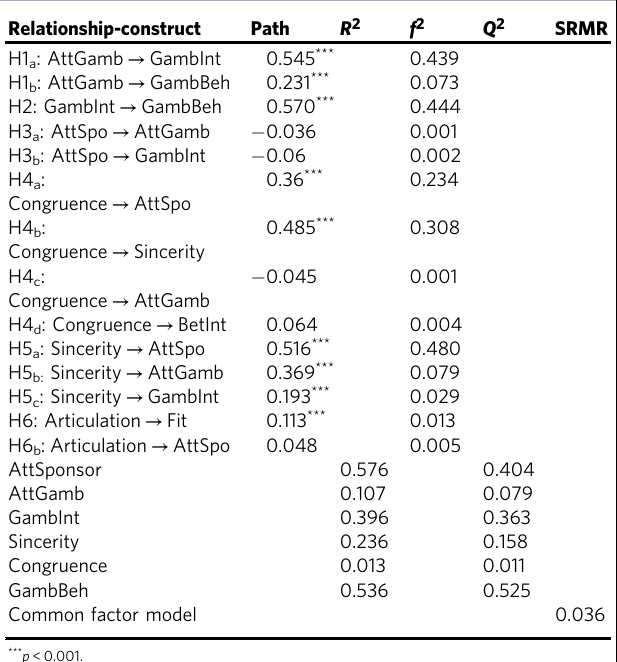
Table 5 Assessment of the structural model (bootstrapping =